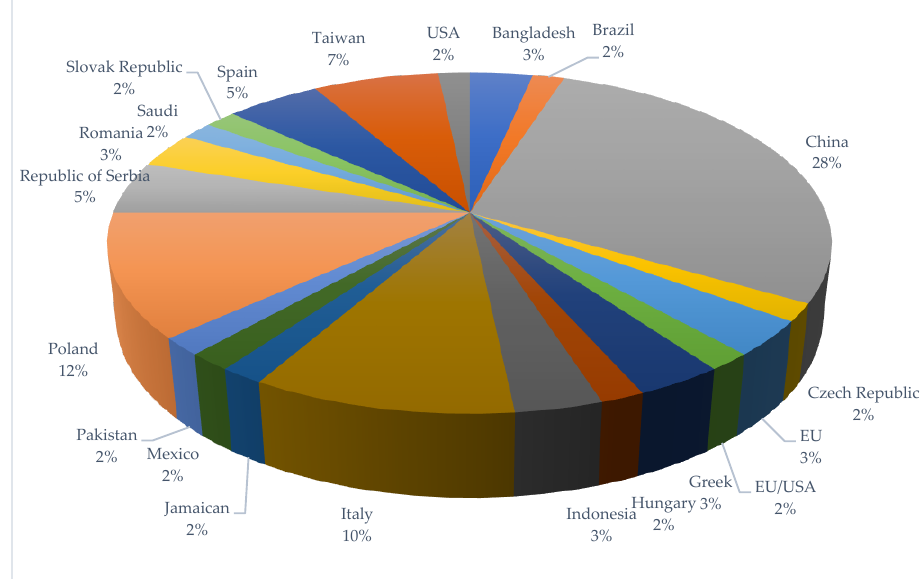
Figure 2. Area in which the 60 papers were concentrated, %.